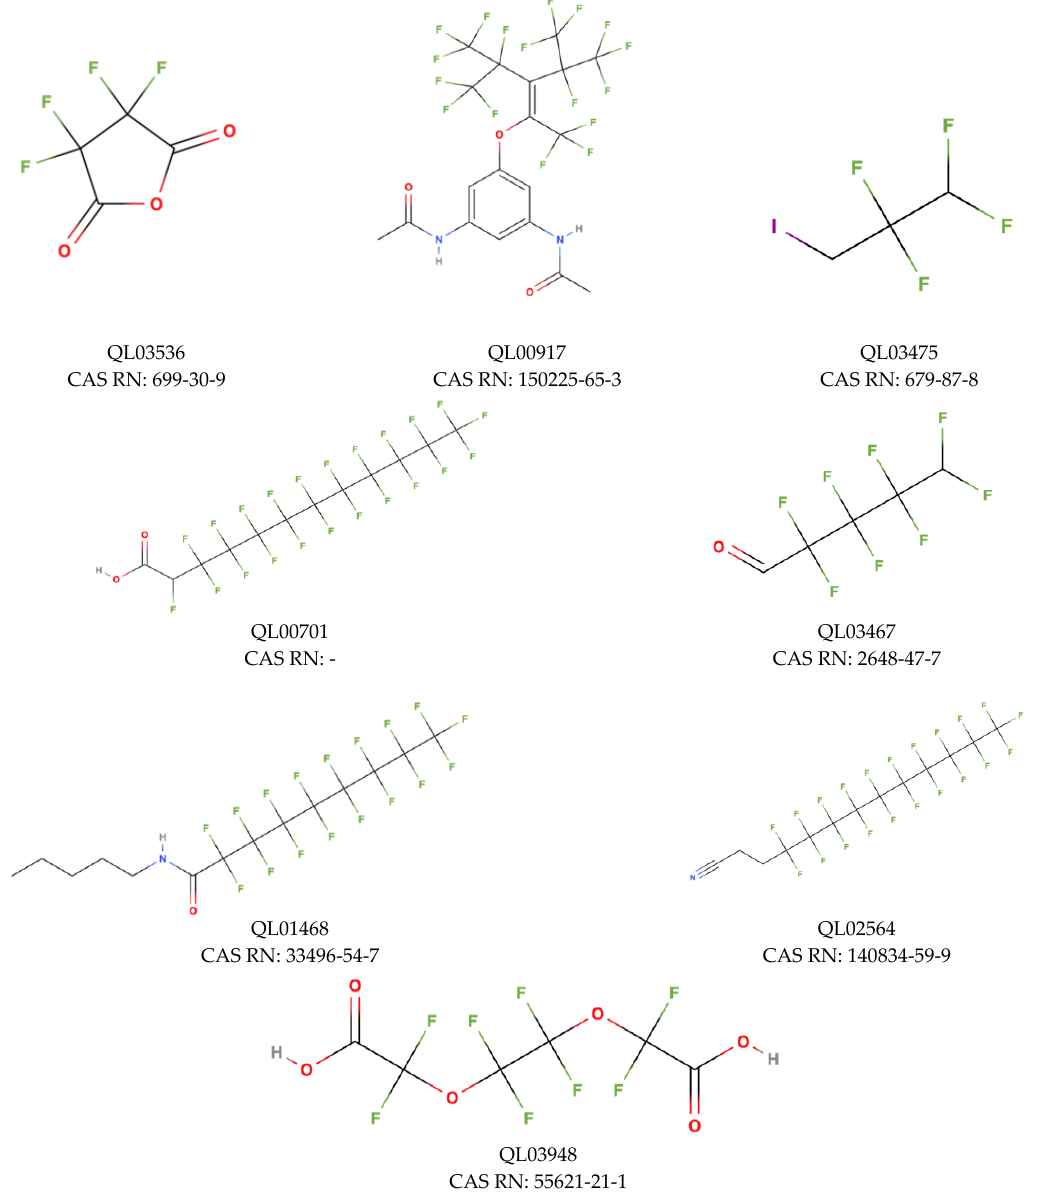
Figure 9. Chemical structure of PFAS selected from NORMAN Database.